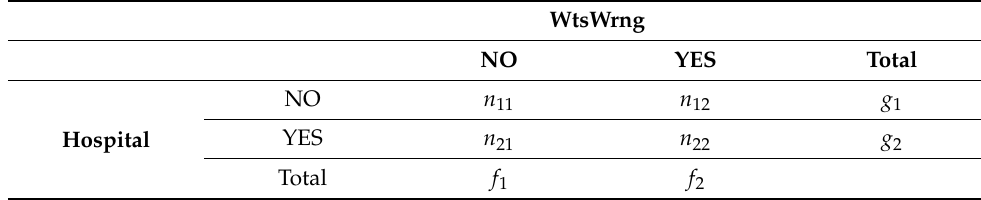
Table 1. Theoretical distribution of subjects by diagnostic sources and response